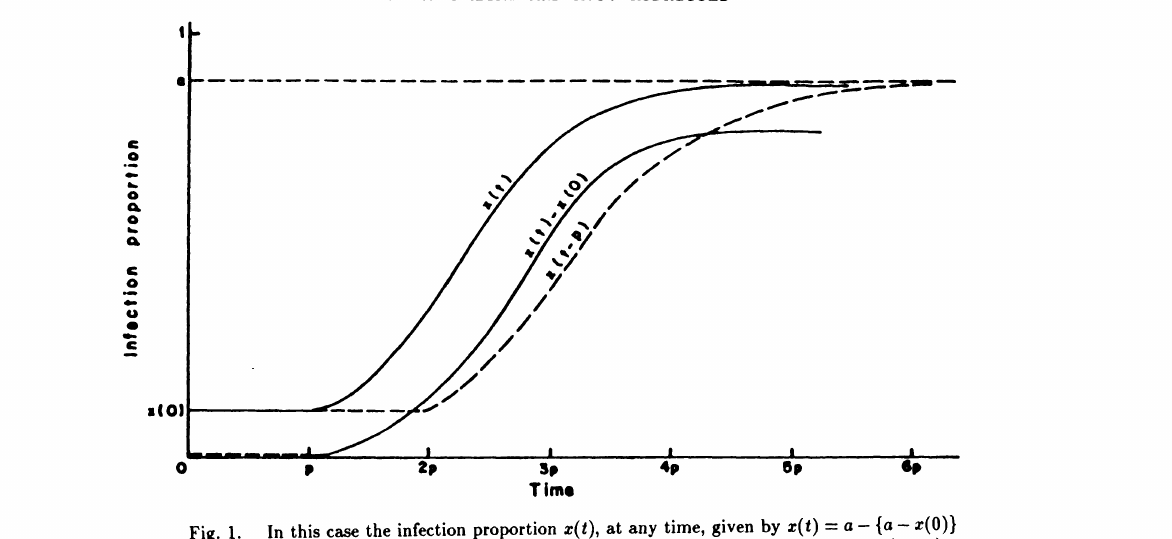
{a- x(O)} Fig. 1. In this case the infection proportion z(t), at any time, given by z(t) a- ezp[- r f {z(t)- z(O)}dt] is compared with the curves {z(t) z(O)} and z(t p). The rate of growth of the theoretical profile dx(t)/dt at t=p is continuous, whereas the rate of growth of the computed profile dXl(t)/dt indicates a discontinuity at t=p. A closer inspection